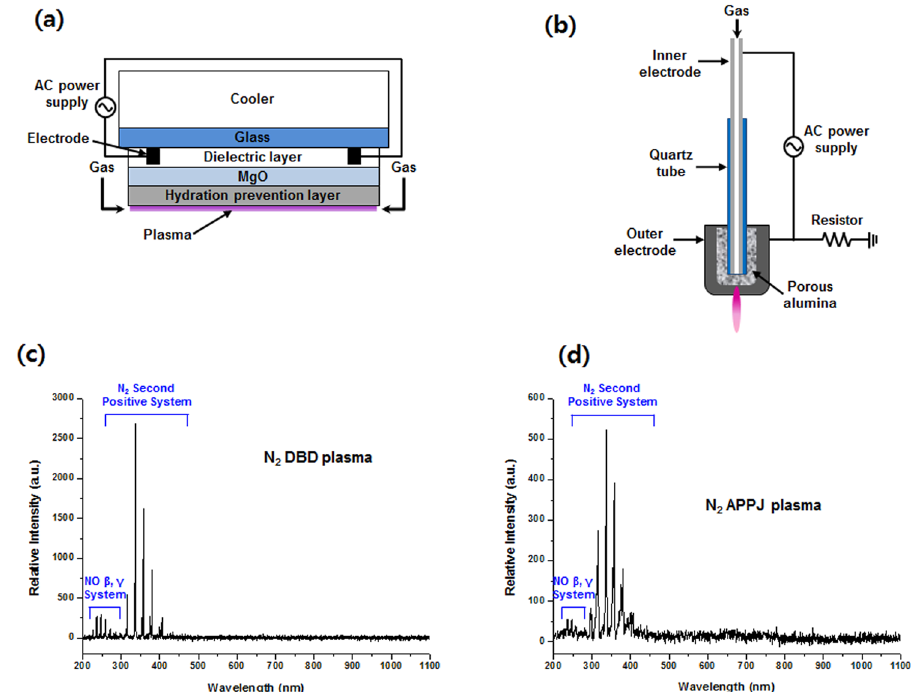
Figure 1. Schematic depiction and optical emission spectra. Schematic depiction of ( a ) dielectric barrier discharge (DBD) and ( b ) atmospheric pressure plasma jet (APPJ) are shown. Optical emission spectra of ( c ) the N 2 -DBD plasma and ( d ) the N 2 -APPJ were observed,